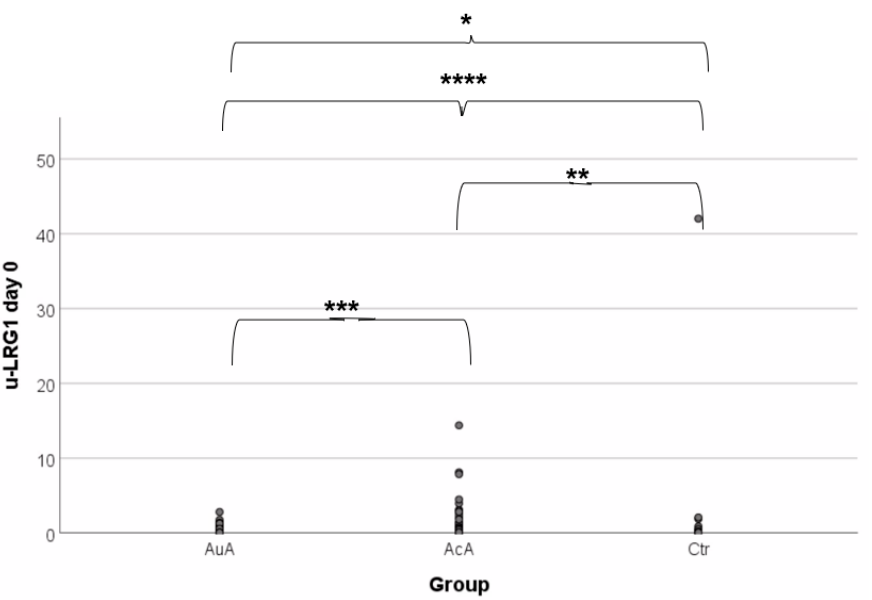
Figure 2. u-LRG1 of each patient group. u-LRG1 levels are increased in patients with AA ( n = 97) compared to the control group ( n = 56), **** p < 0.001. u-LRG1 was not able to detect disease progress when analyzing AcA ( n = 52) and AuA ( n = 45), *** p = 0.089. A significant difference ** p = 0.005,